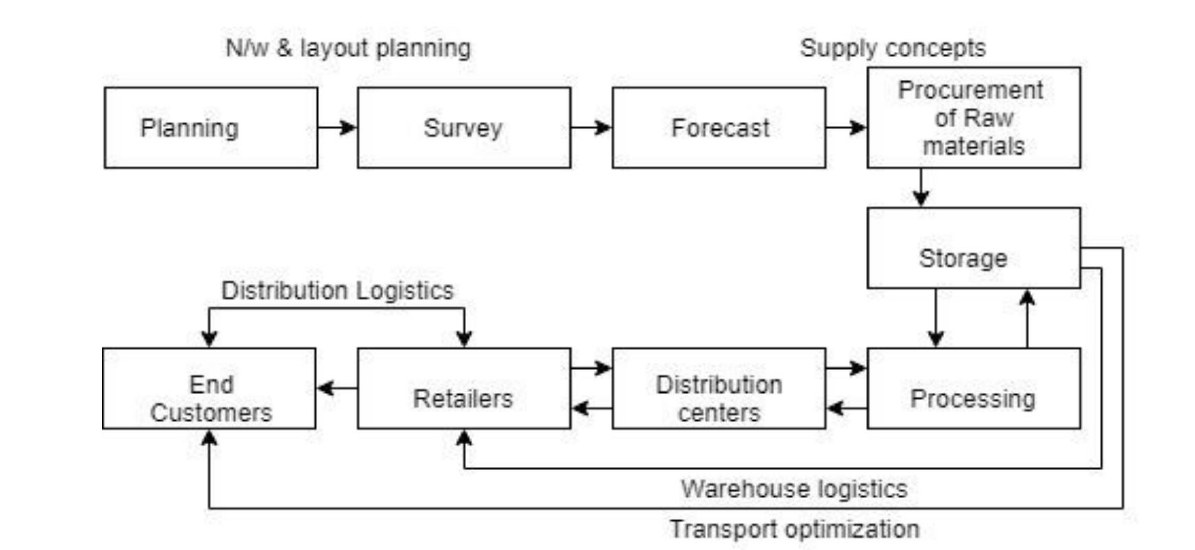
Figure 1: Process of supply chain